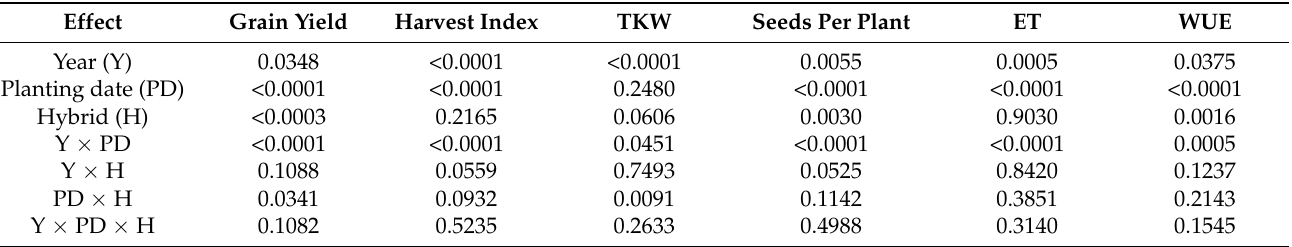
Table 1. ANOVA ( p -values) for grain yield, harvest index, thousand kernel weight (TKW), seeds per plant, evapotranspiration (ET), and water use efficiency